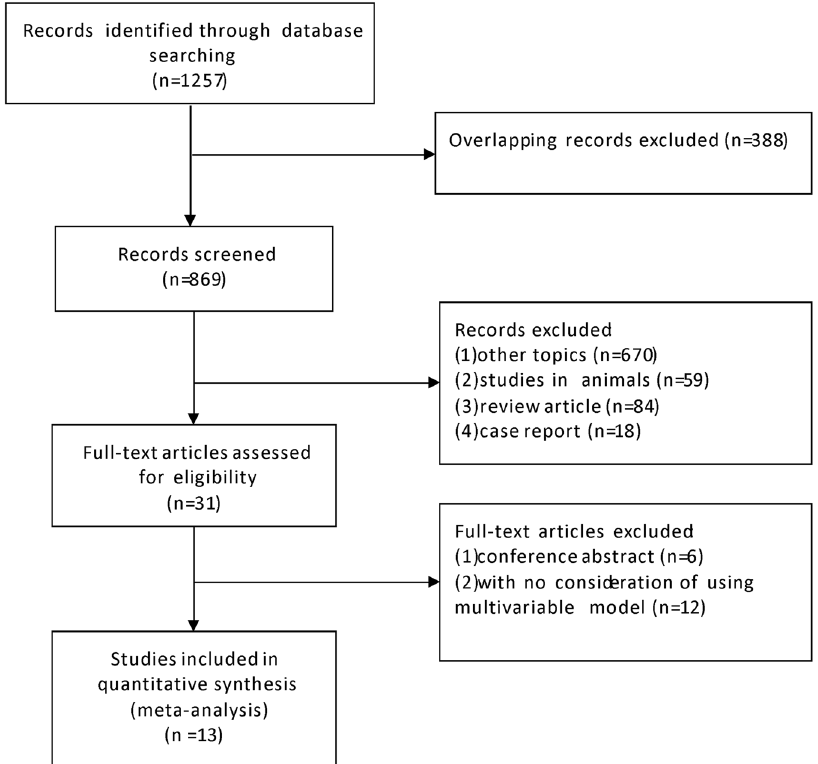
Figure 1. Flow diagram of included